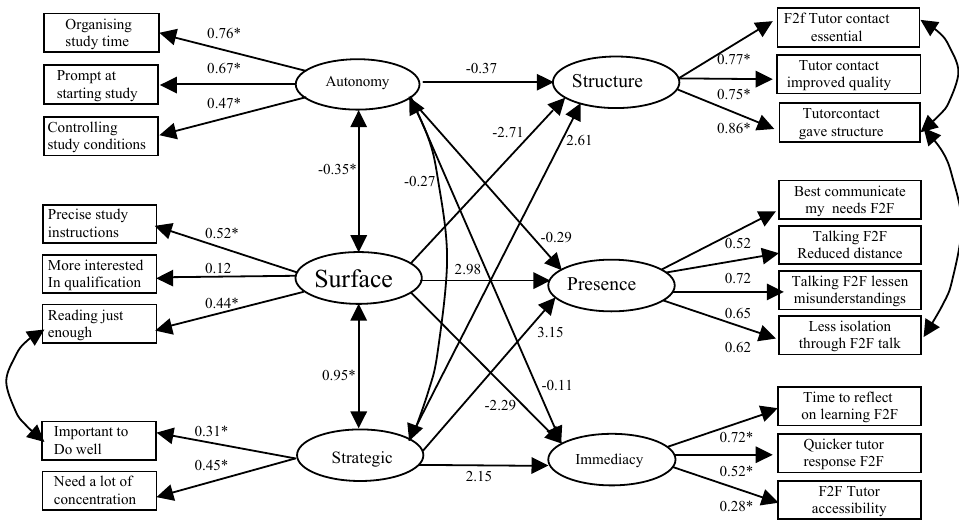
Figure 3. Structural equation model (modality model: face to face). χ 2 (120) = 171.08, p < 0.001, CFI = 0.92, RMSEA =